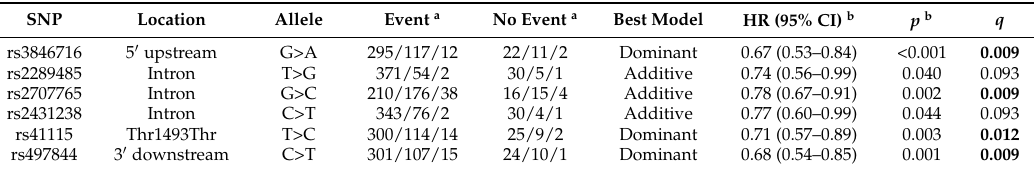
Table 1. Association between htSNPs in APC and disease progression in prostate cancer patients treated with ADT.